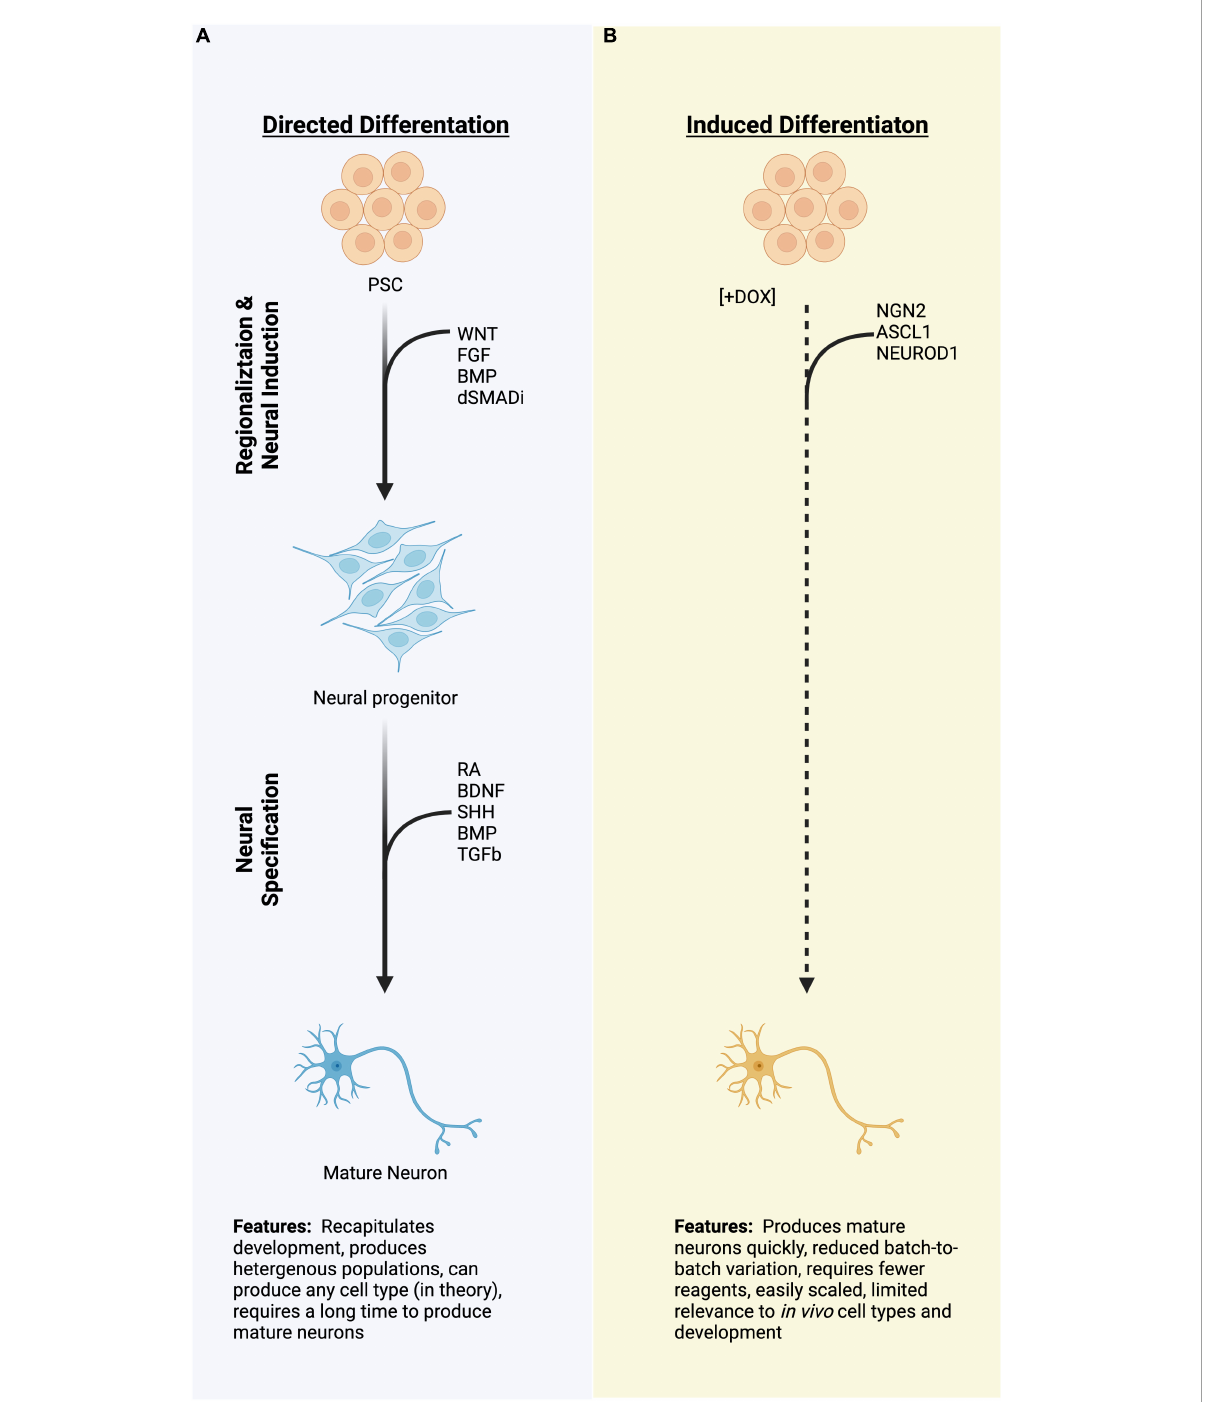
FIGURE1 A schematic diagram of two strategies for differentiating pluripotent stem cells (PSCs) to neurons. (A) Directed differentiation employing exogenous manipulation of common signaling pathways to produce neural progenitors and neurons. (B) Induced differentiation from PSCs using overexpression of proneural transcription factors which quickly produce a neuronal molecular fate. Dashed lines represent rapid processes due to induced TF expression as compared to the directed differentiation, which typically take a longer time. PSCs, pluripotent stem cells; TFs, transcription factors; miRNA; (Created with